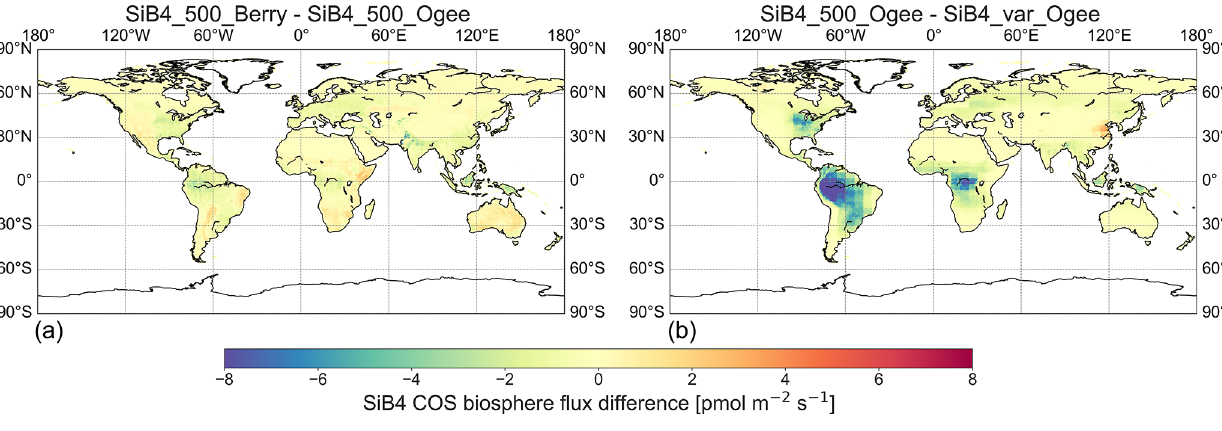
Figure 6. COS biosphere flux difference between two SiB4 model runs. (a) Difference between SiB4_500_Berry and SiB4_500_Ogee to show the flux difference between the soil models. (b) Difference between SiB4_500_Ogee and SiB4_var_Ogee to show the effect of changing to variable mole fractions. Negative values indicate a drop in the biosphere COS